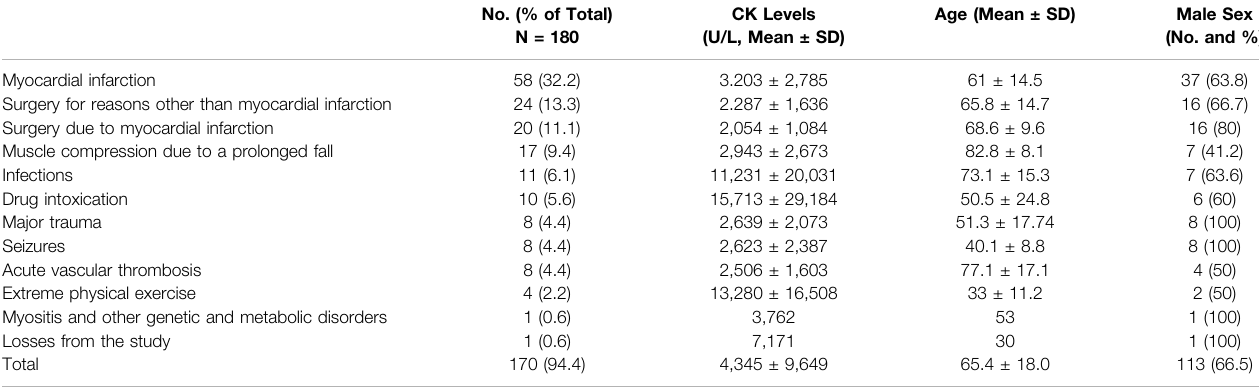
TABLE 1 | Patients with a rhabdomyolysis alert who met exclusion factors due to underlying diseases that explained the analytical alteration.